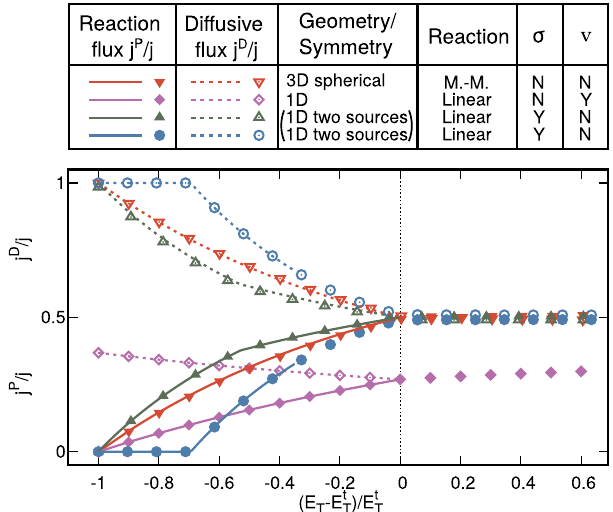
Fig. 3 Test of the general condition for transitions in the optimal enzyme arrangement. The local reaction fl ux, j P ð s Þ , and net diffusive fl ux, j D ( s ), as a fraction of S in fl ux, j ( s ), are plotted for different models against the amount of enzymes in the system, E T , rescaled by the transition amount, E t cases, j D > j P until they coincide at the transition point, as predicted by Eq. (10). When v = 0, j P ¼ j D ¼ j = 2 at and above the transition. Lines show analytical solutions of the constrained optimization, while points represent numerical optimizations. For the two-source model, the two curves show the two unequal sources, each rescaled with the corresponding E t see Supplementary Note 6 and Fig. S1 for a detailed analysis of this model. The data plotted in the fi gure are provided as Supplementary Data